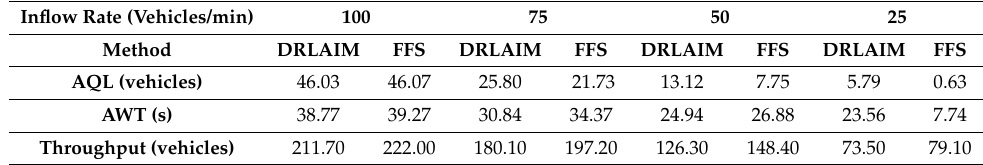
Table 10. Comparison with FFS